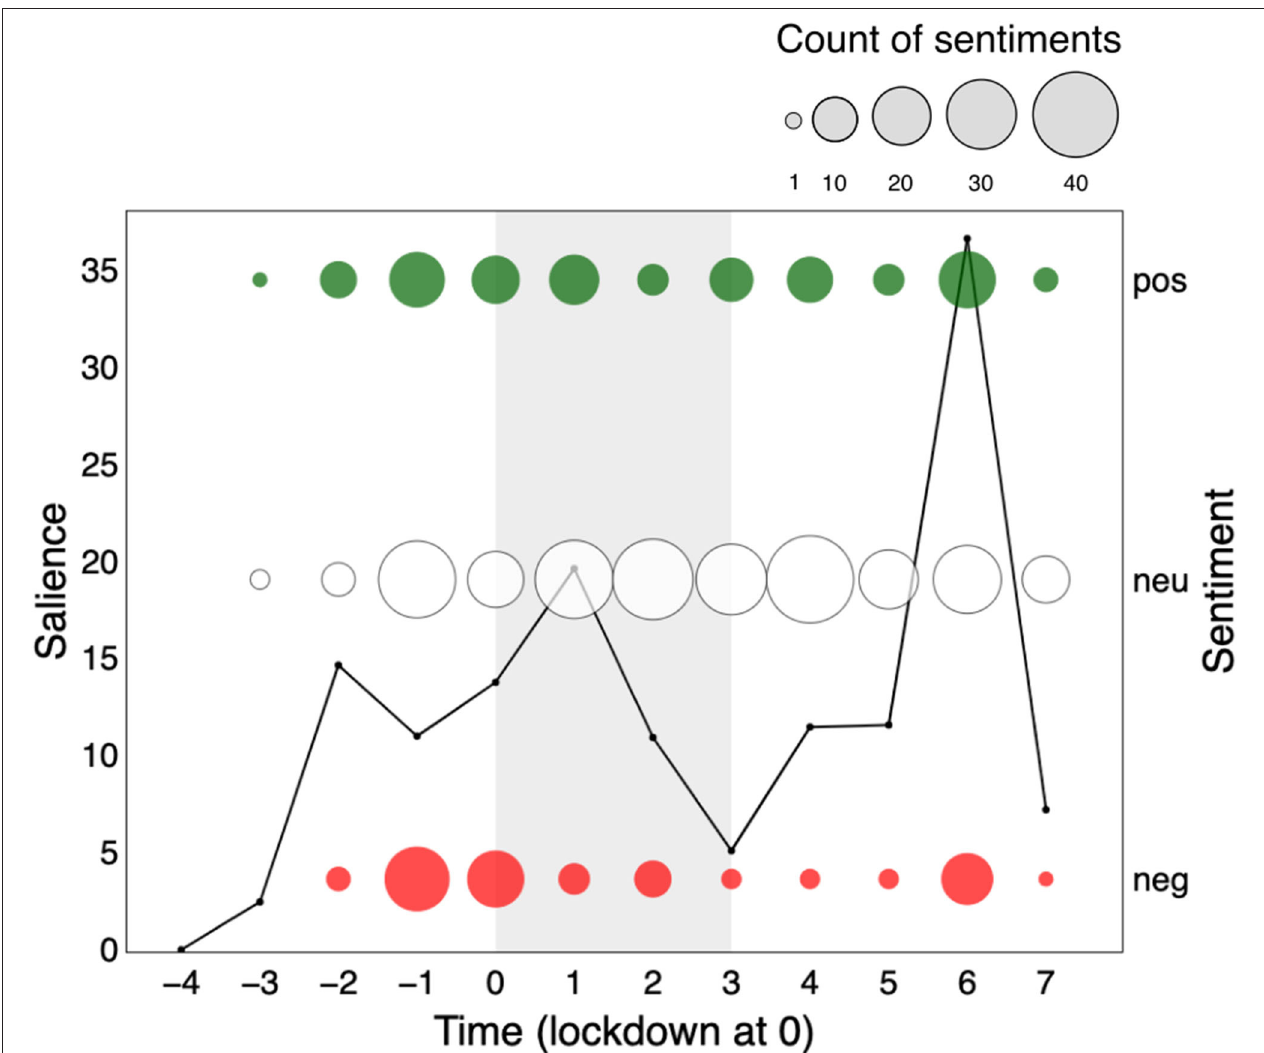
FIGURE 2 | Salience of and sentiment toward the keyword “ behavioural science ” over a 12 two-week time-period surrounding the first British national lockdown of 2020 (gray area) in print media (top 15 UK newspapers). Salience is calculated for a 2-week period as the normalized keyword frequency (per 10,000 words) multiplied by the proportion of articles that mention the keyword. Sentiments are represented in counts of positive ( + 1 or + 2), neutral (0), and negative ( − 2 or − 1) bubbles over time, in green, white and red respectively. The size of the bubble is proportional to the count of sentiments in that polarity class toward the